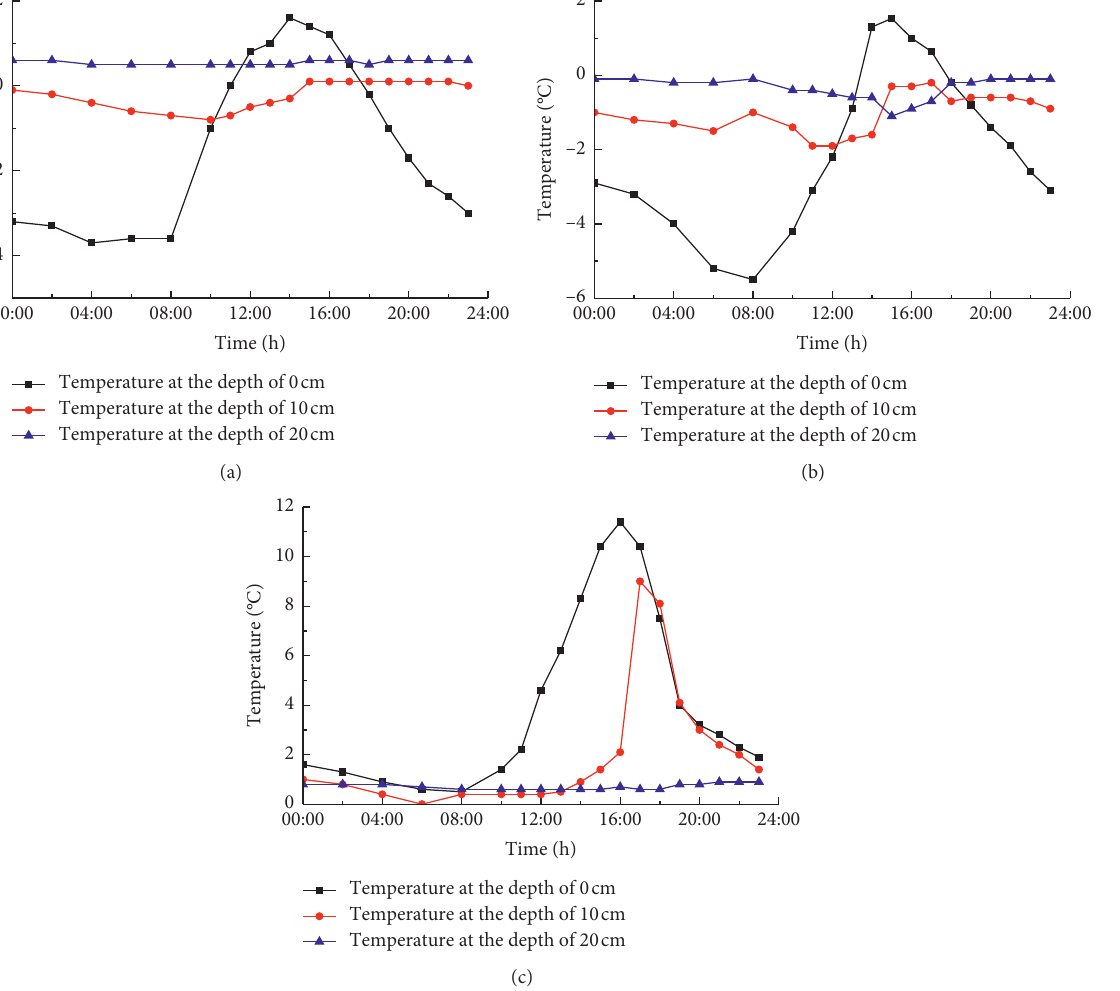
Figure 4: Daily variation of temperature at different depths of the surface in Bin County. (a) December 10 th . (b) January 10 th . (c) March 10 th